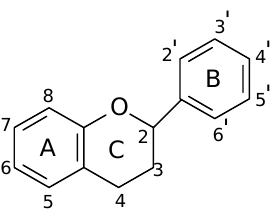
Figure 1 . Basic flavonoid